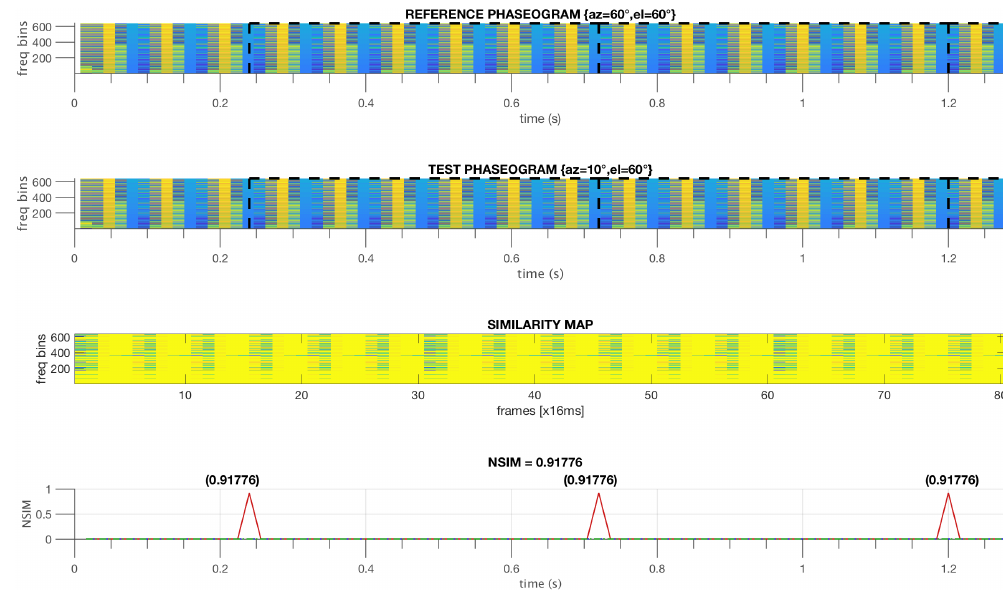
Figure 8. Phaseograms, similarity map, and similarity scores for 100 Hz pure sine wave signals. The Reference signal is localized at Azimuth = 60 ◦ , Elevation = 60 ◦ , the Test signal at Azimuth = 10 ◦ , Elevation = 60 ◦ and resulting localization accuracy score is